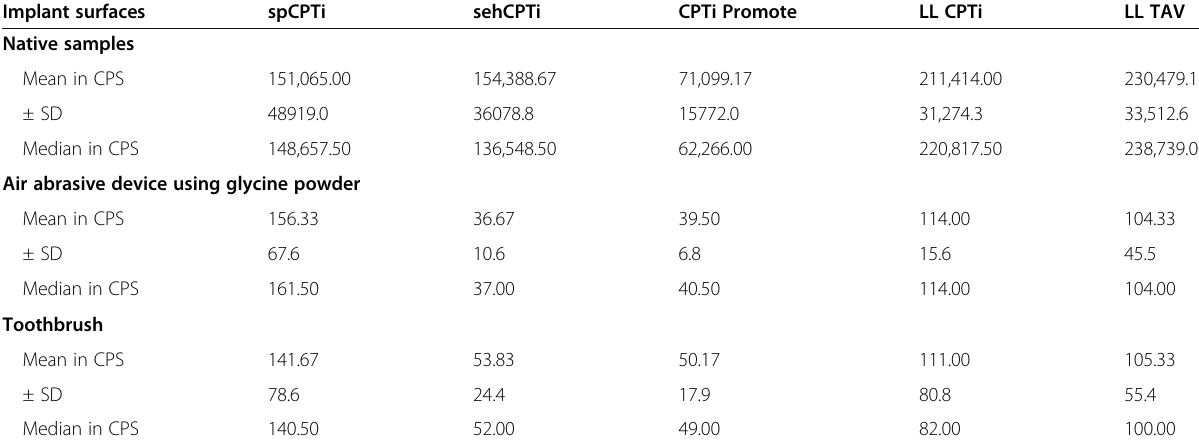
Table 3 Overview on cell viability in mean counts per second (CPS) with corresponding standard deviations as well as medians regarding the groups Implant